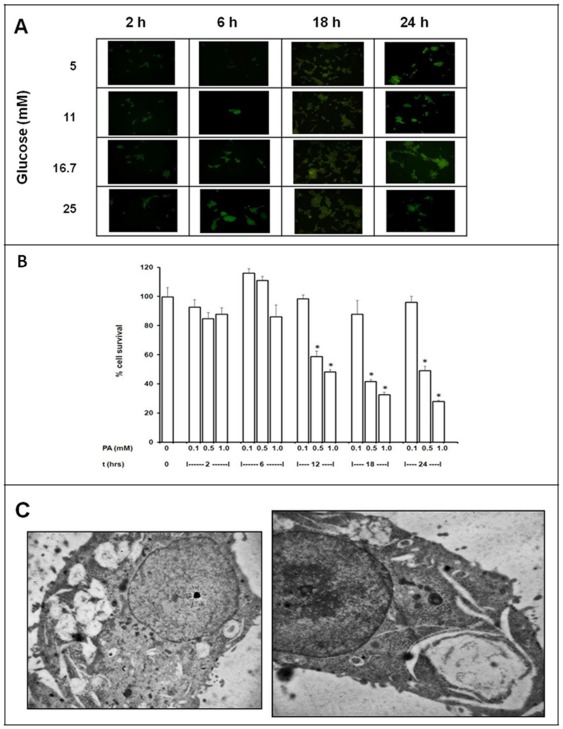
Effects of various incubation times (2–24 h) different palmitic acid (PA) concentrations (0.1, 0.5 and 1.0 mM) in INS-1E cells.
A) MDC fluorescence, as indicator of autophagosome formation; B) cell viability; C) ultrastructure (0.5 mM PA for 24 h) (magnification: 10.000×).